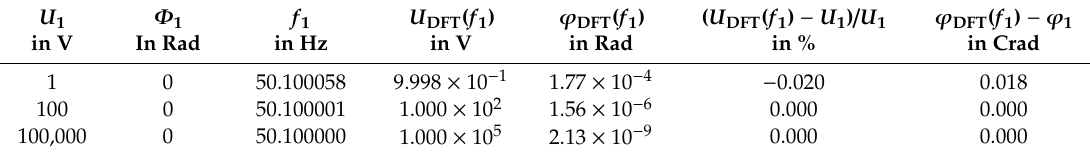
Table 2. Experimental SV device-based amplitude and phase values of the three received signals without resampling processing and of the three resampled signals by using the modified sinc algorithm as well as the three corresponding errors between the signals with and without resampling processing. The signals are simulated with parameters of f S = 4000 Hz, T W = 1 s, f 1 = 50.1 Hz, and ϕ 1 = 0 ◦ with di ff erent RMS values of the amplitude U 1 = 1 V / 100 V / 100 kV, without the noise and the harmonic series. The modified sinc algorithm are simulated with parameters of q = 6 and N F =